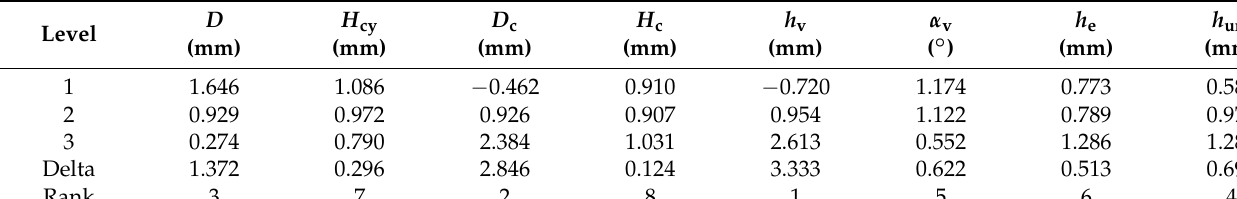
Table 10. The average SNR response table for σ .